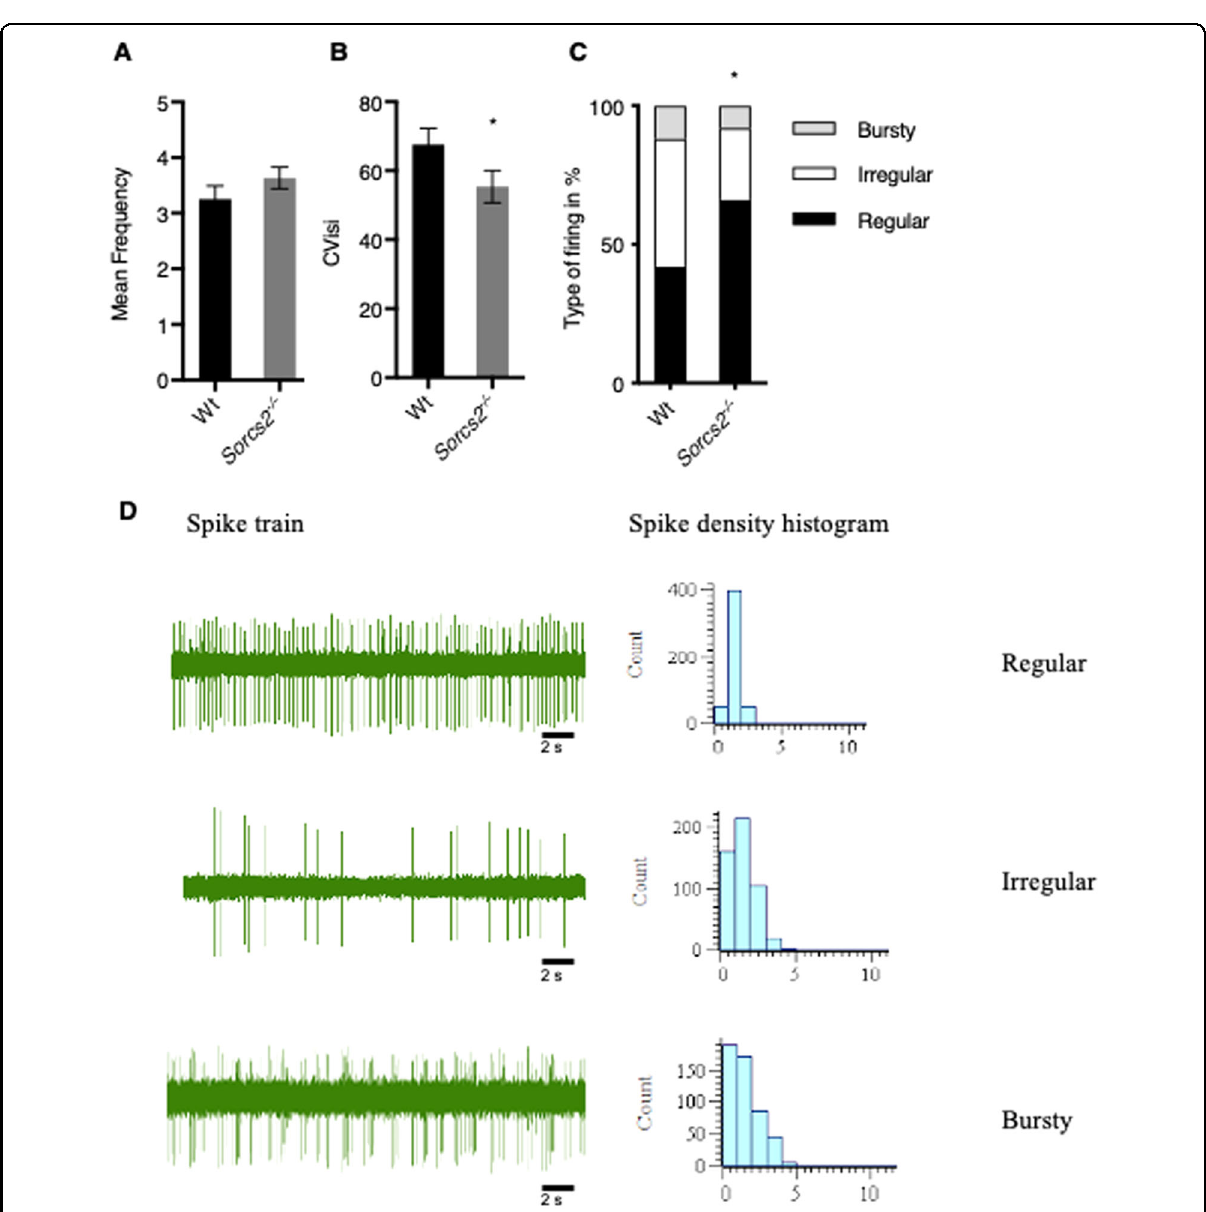
Fig. 1 Dopaminergic neurons in the VTA in Sorcs2 − / − mice fi re more regularly compared to Wt mice. A Dopaminergic neurons in the VTA fi re with similar frequency in Wt and Sorcs2 − / − mice ( p > 0.2, Students unpaired t -test). B lower CVisi in Sorcs2 − / − mice ( p < 0.03, Students unpaired t -test). C Sorcs2 − / − mice have a higher population of regular fi ring neurons (Chi-square test, Χ 2 = 6.59, df = 2, p < 0.003). D Representative spike density histogram (right column) of dopaminergic neurons in the VTA, constructed from spike trains (left column). Neurons were either classi fi ed into regular (upper row), irregular (middle row), or bursty (lower row). 48 neurons were recorded in Wt mice (from 10 animals) and 63 neurons recorded in Sorcs2 − / − mice (from 12 animals). * p <